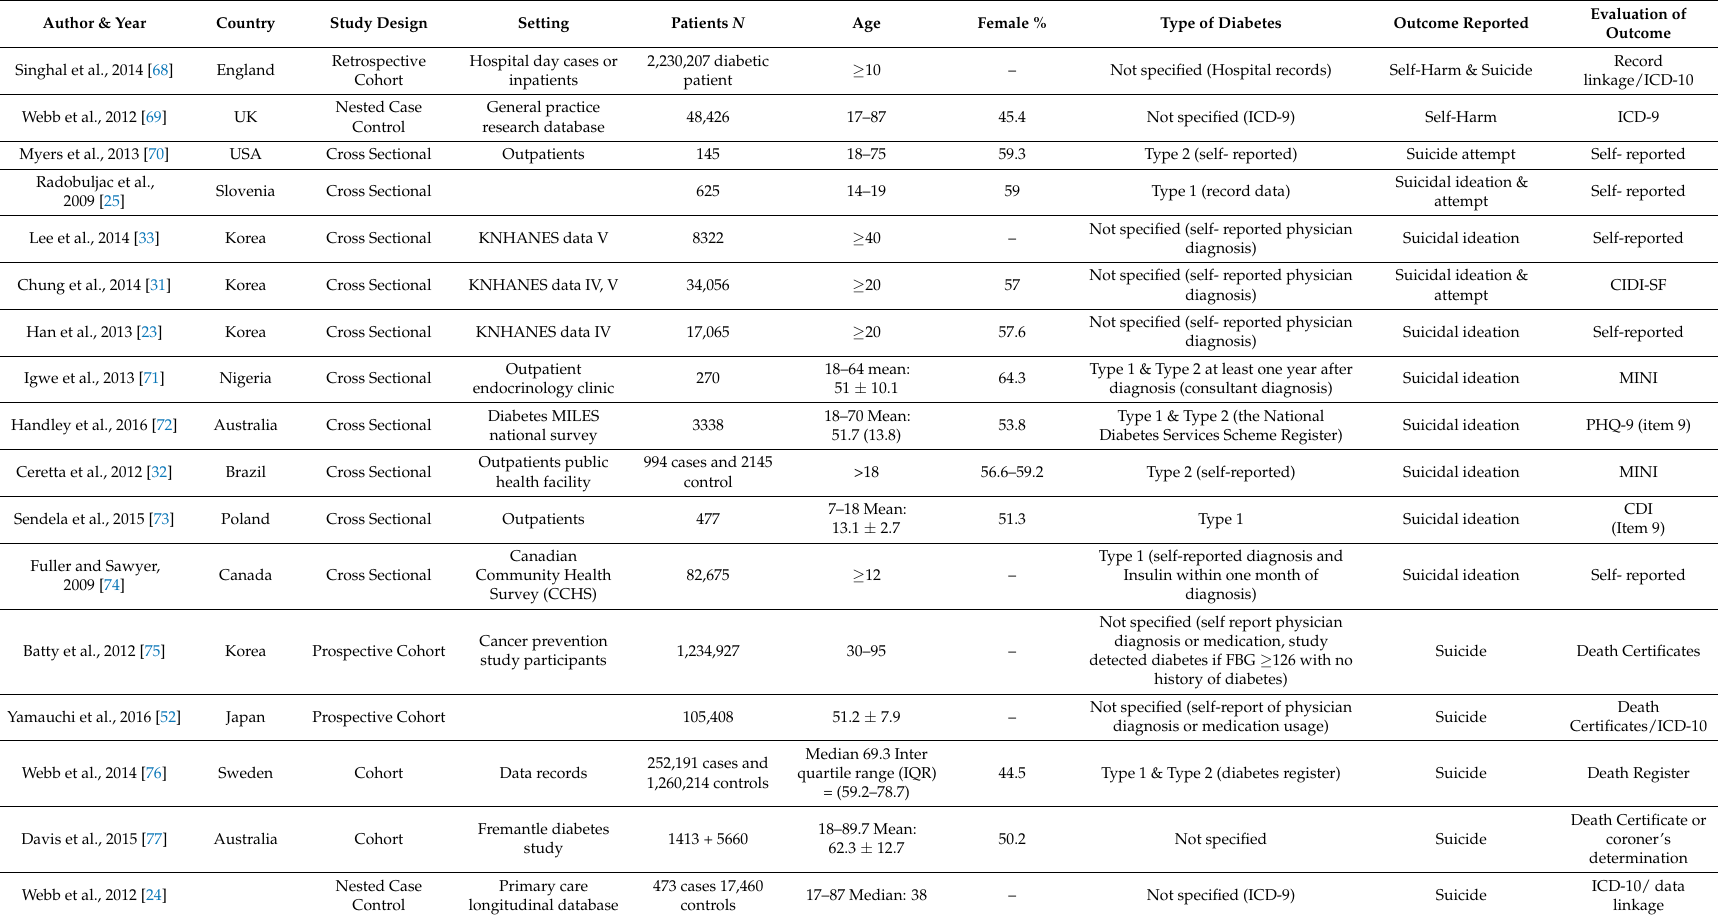
Table 3. Characteristics of selected suicidality